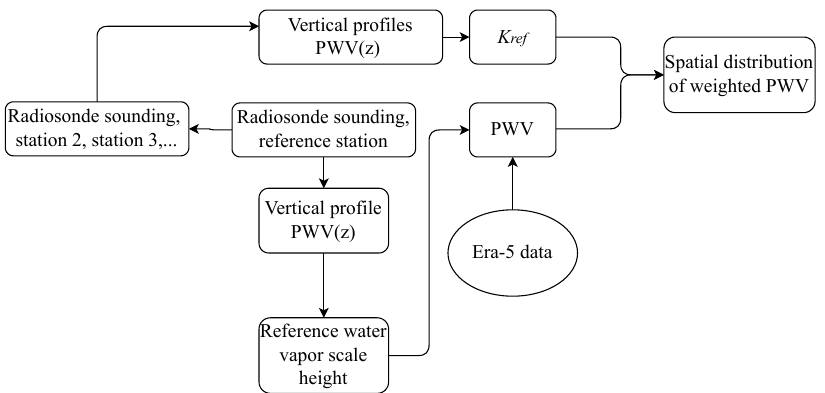
Figure 2. Flowchart of the method for correcting PWV . The values of PWV are computed using the radiosonde sounding at the nearest reference station. Additional radiosonde stations provide correction of PWV distribution within the